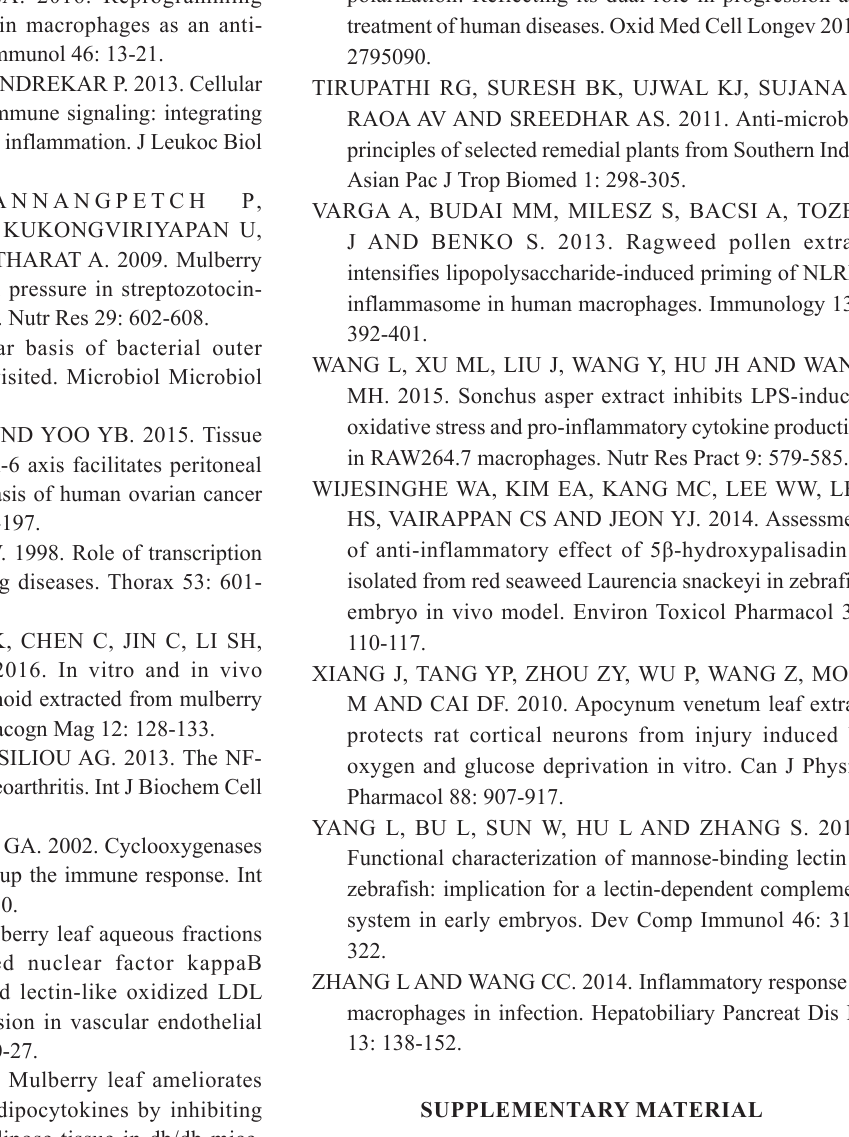
Figure S1 – The leaves of M. alba L. (This photo was taken from http://www.cirrusimage.com/tree_weeping_white_